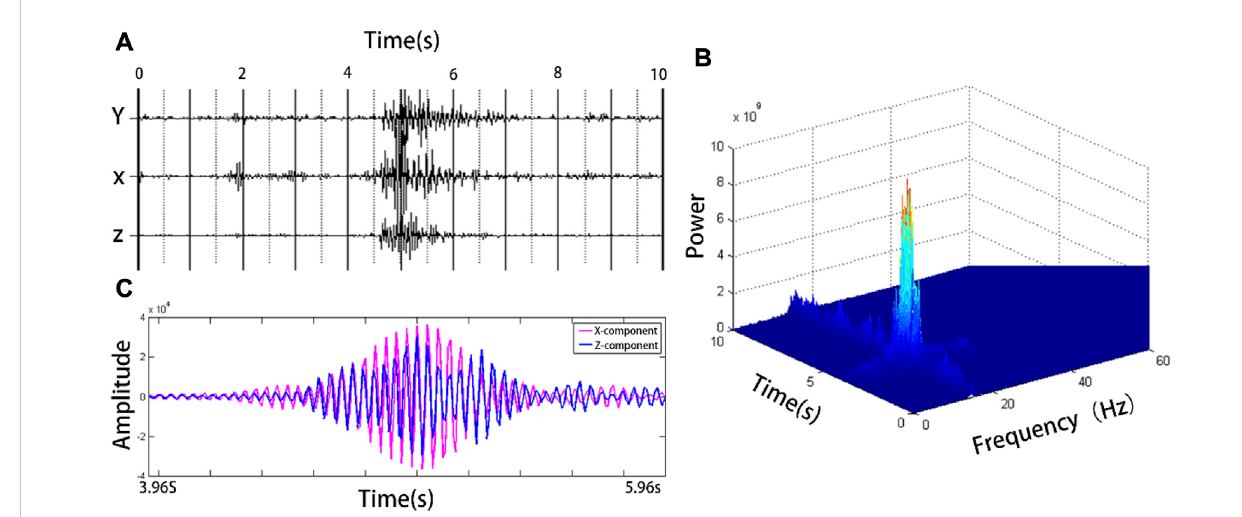
FIGURE 10 (A) showsthehorizontalandverticalcomponentseismicrecordsofthebodywavedominantmicrotremorsignal,and (B) showsthetime-frequency distribution of the vertical component in (A) ; (C) Is the comparison of seismic records after bandpass fi ltering.